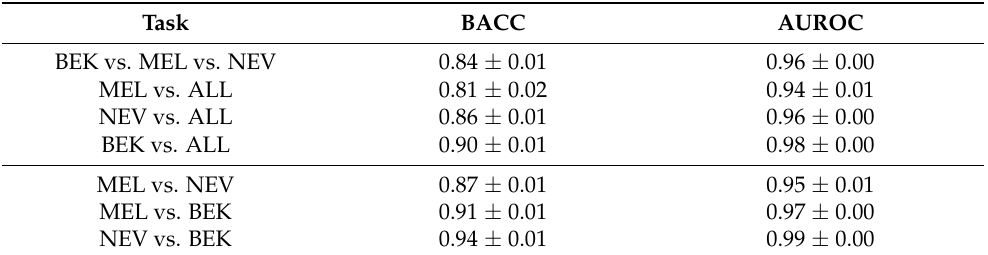
Table 2. Performance on the test set for each of the seven models on different tasks involved in our framework. We report on table the BACC and the AUROC scores. Task BACC BEK vs. MEL vs. NEV